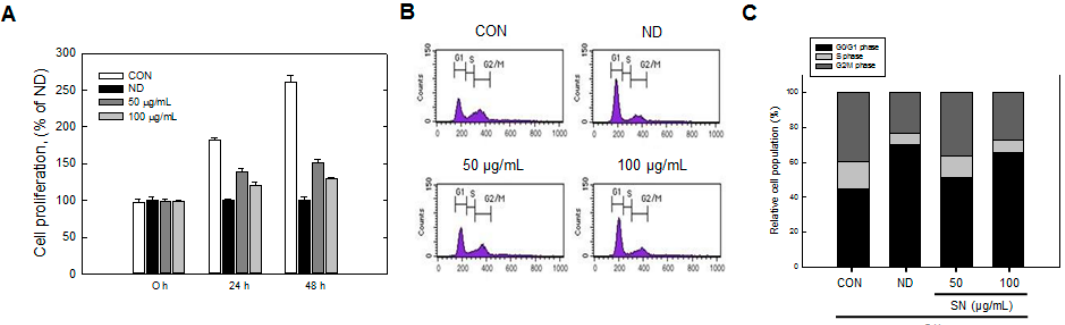
Figure 5. Effects of SN on cell cycle progression of 3T3-L1 cells during differentiation. ( A ) After differentiation for 24 or 48 h, the number of cells stained with trypan blue was determined using a hemocytometer; ( B ) 3T3-L1 cells, in which differentiation was induced by treatment with a hormone cocktail with or without SN for 24 h, were harvested, fixed with 70% ethanol and stained with propidium iodide. Stained DNA was analyzed using a flow cytometer; ( C ) The cell population at each stage of the cell cycle was determined using the BD CellQuest Pro software (version 3.01, Becton Dickinson, San Jose, CA, USA). CON: control, SN: seapolynol, ND: non-differentiated 3T3-L1, G1: growth 1 phase of the cell cycle, S: synthesis phase of the cell cycle, G2/M: growth 2 and mitosis phase of the cell